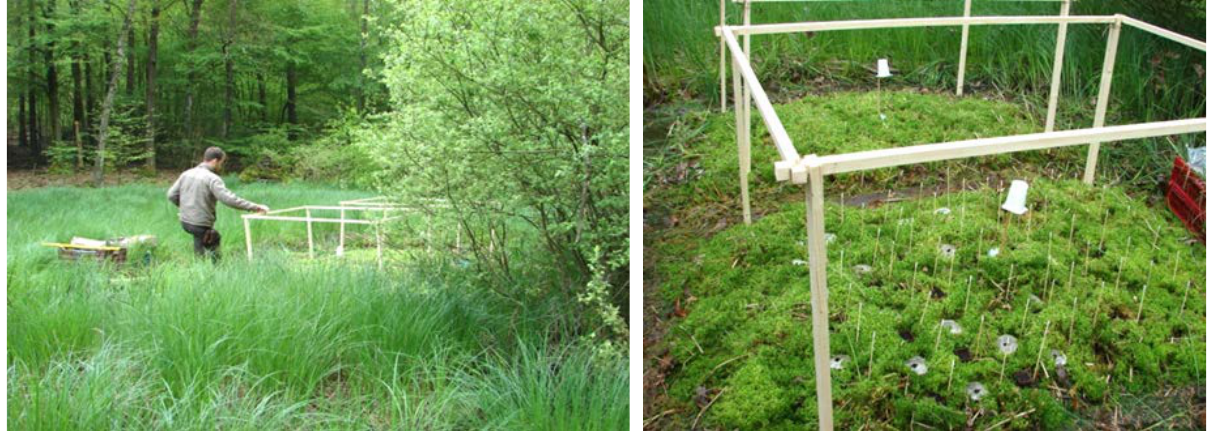
Figure A2. Permanent quadrats in “Fekete-tó” in 2014: installation of the experiment (left) and installed permanent quadrat before fixing the bird net (right). Photos: Balázs Baranyai.